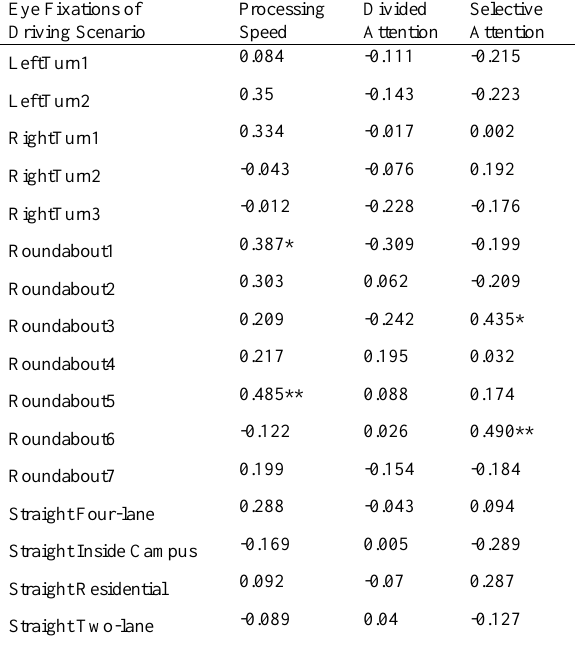
Correlation coefficients between visual capacity and maximum fixation duration at different driving scenarios (*p<.05; **p<.01,